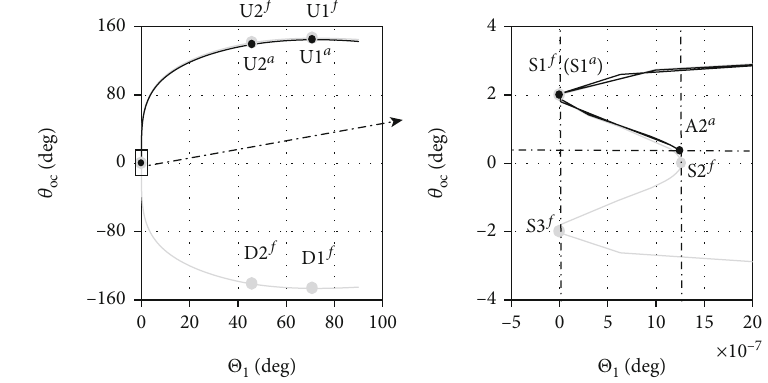
Figure 13: Bifurcation curves of DS landing